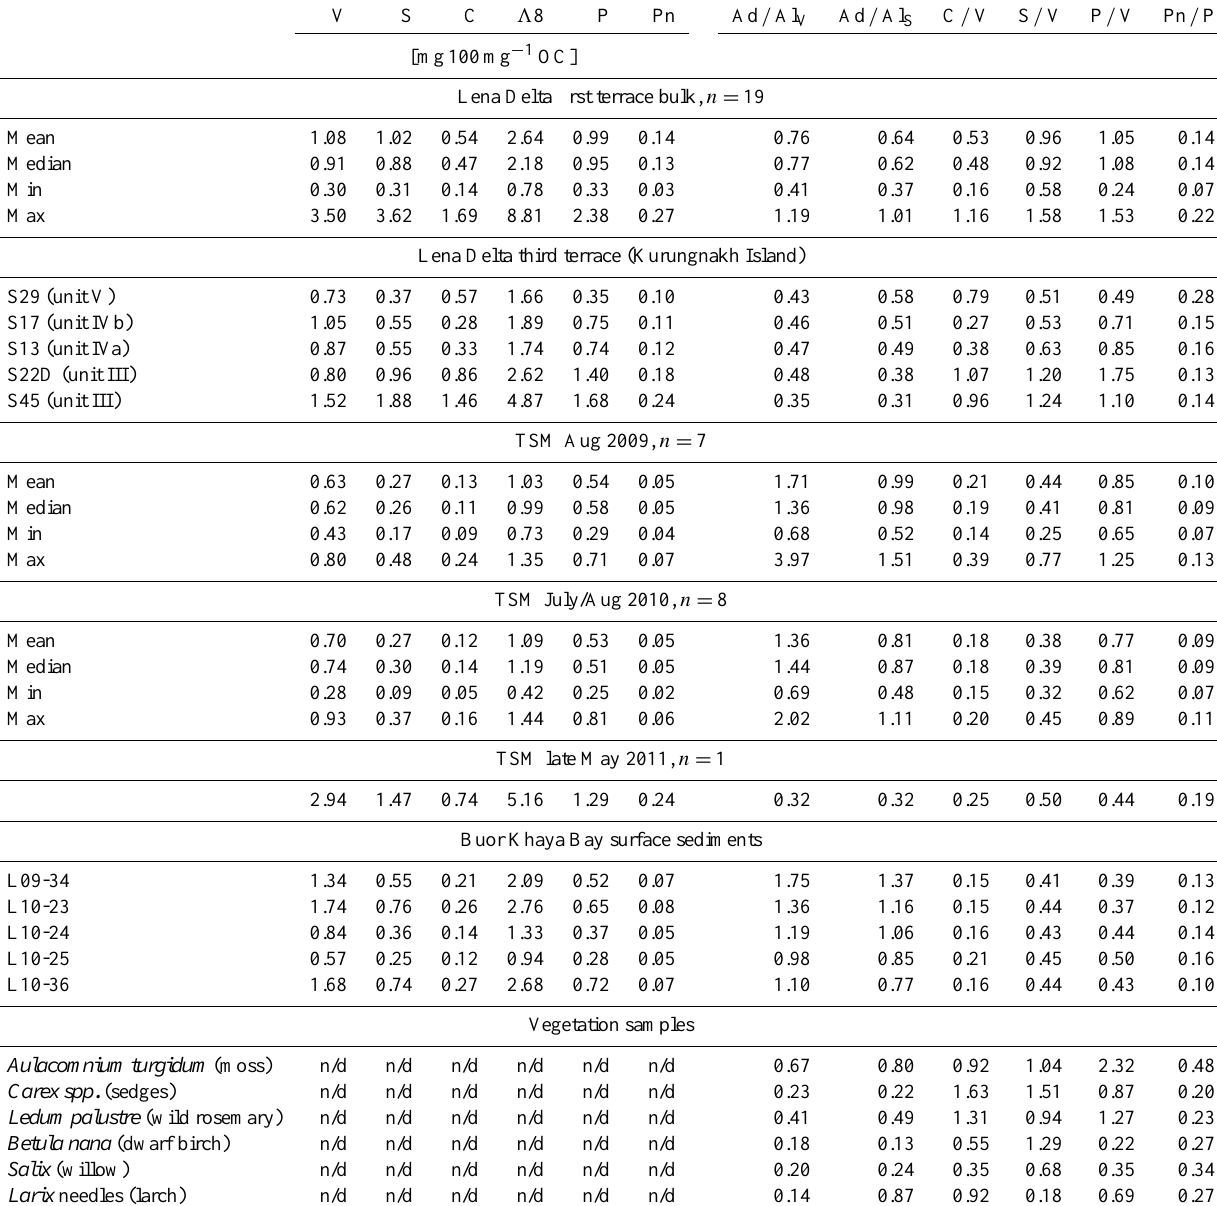
Table 5. Carbon-normalized yields of CuO oxidation products of Lena Delta soils, surface water total suspended matter (TSM), and sur- phenol groups are the same as in Table 4. Ad / Al V : acid to aldehyde ratio of vanillyl phenols; Ad / Al S : acid to aldehyde ratios of sy- ringyl phenols; C / V: cinnamyl to vanillyl phenols; S / V: syringyl to vanillyl phenols; P / V: p -hydroxybenzenes to vanillyl phenols; Pn / P: p -hydroxyacetophenone to p -hydroxybenzenes. Not determined denoted by n/d.